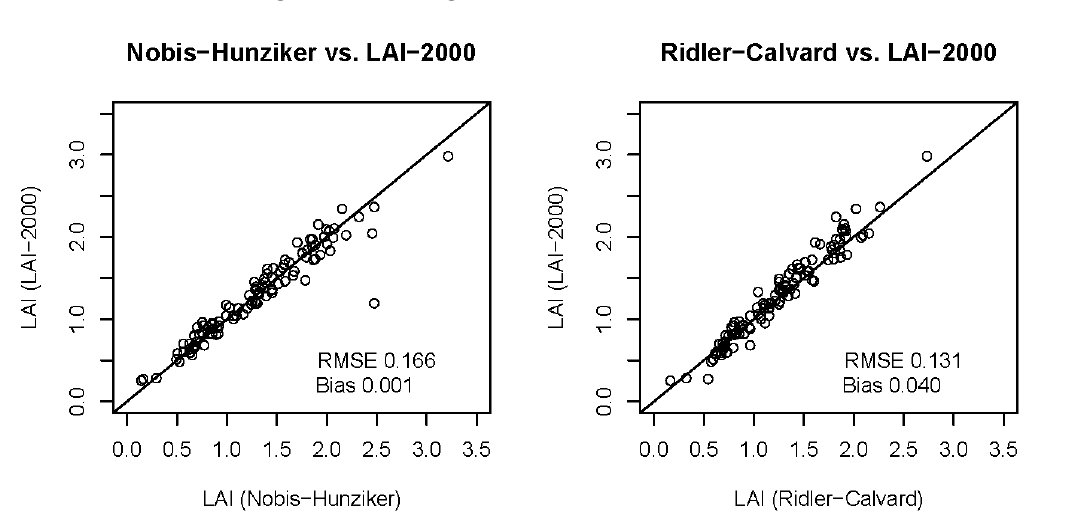
Figure 3. Image thresholding methods validated with LAI-2000 data.